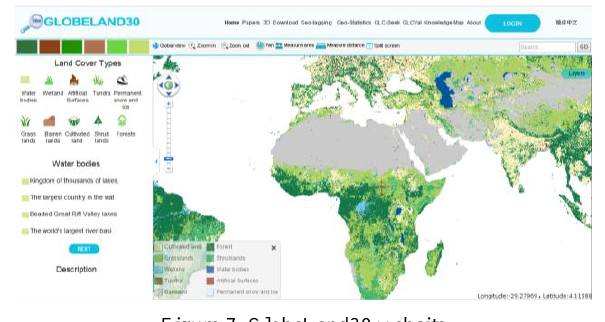
Figure 7. GlobeLand30 website.